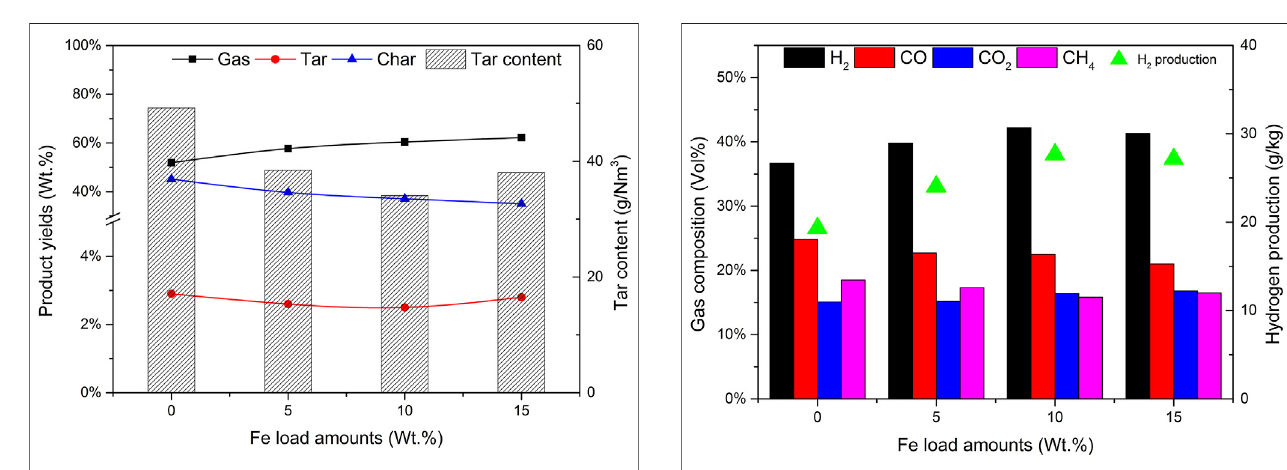
FIGURE2| EffectofFeload amounts on product yields and tarcontent. FIGURE3| EffectofFeloadamountsongascompositionandhydrogen